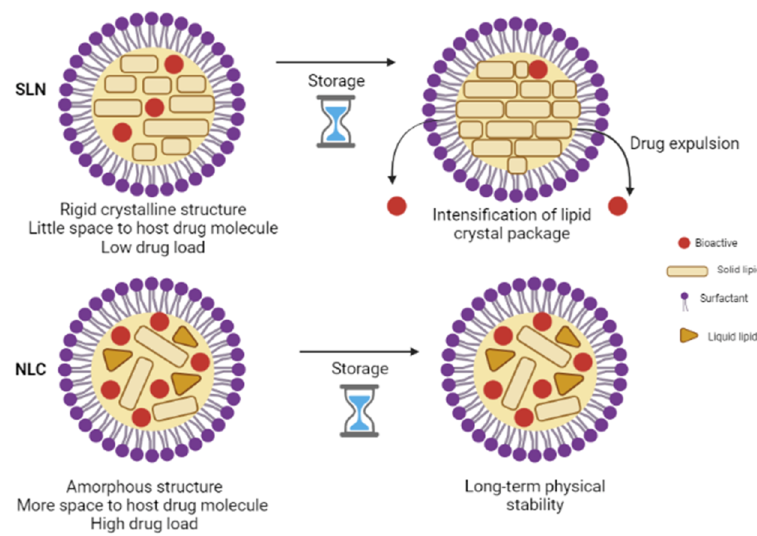
Figure 1. Comparative structure of SLN and NLC.